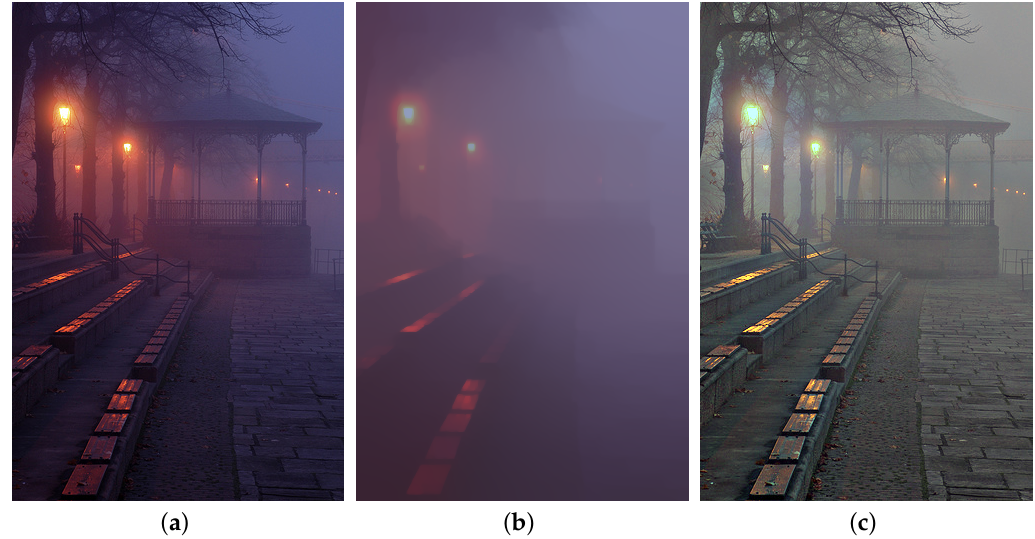
Figure 3. A sample of ambient illumination decomposition. ( a ): scene layer, ( b ): estimated ambient illumination, ( c ): estimated